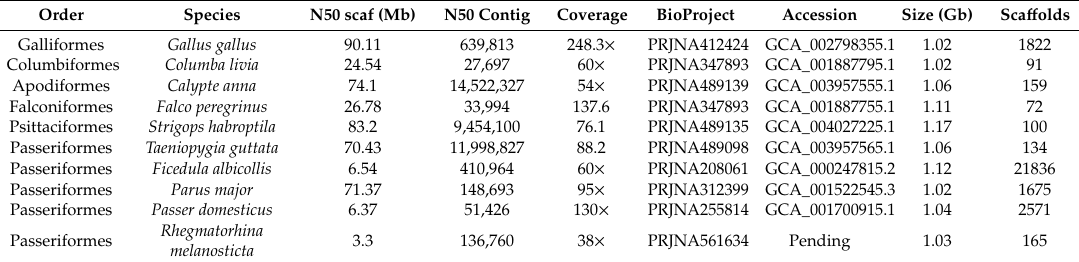
Table 1. List of genomes used as reference to Rhegmatorhina melanosticta genome